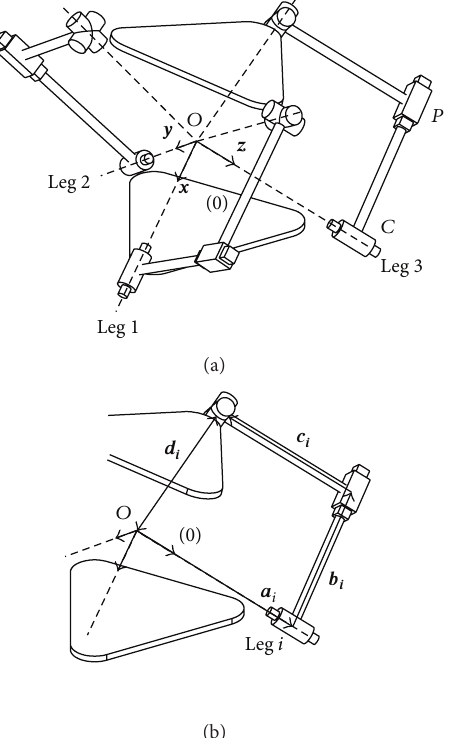
Figure 1: Kinematic schemes of the 3-CPU robot (a) and geometry of the legs